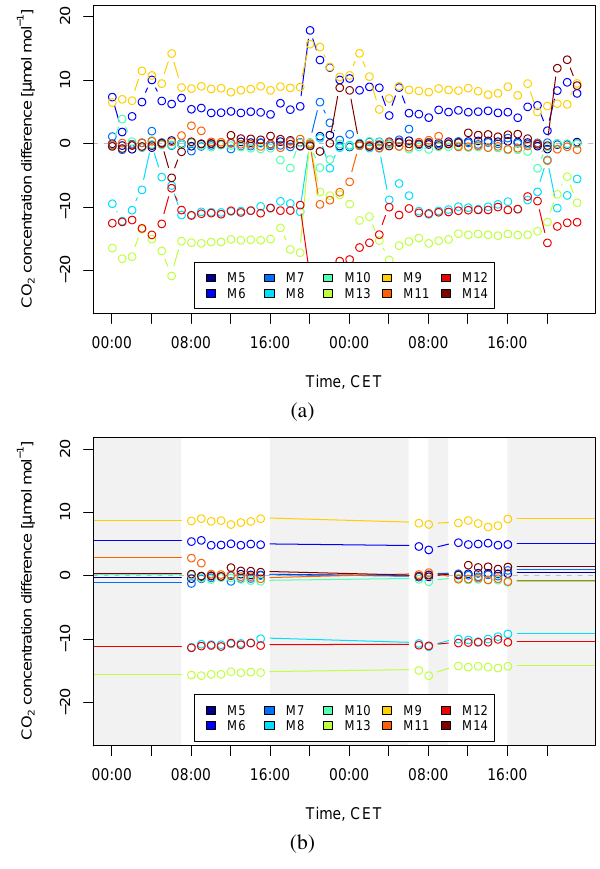
Fig. 9. Time series of the modes of density distributions of concen- tration differences c i (t) − ˜ c(t) (see Fig. 7a for example distributions for one 60-minute time step) for 10 sampling locations on 29 June and 30 June 2008, before filtering with mixing index (a) , and after filtering with mixing index MI c =0.13 (b) . Modes from periods which satisfy MI < MI c are not used during bias correction (grey mask). The last mode at a time with MI ≥ MI c is used instead (solid lines).